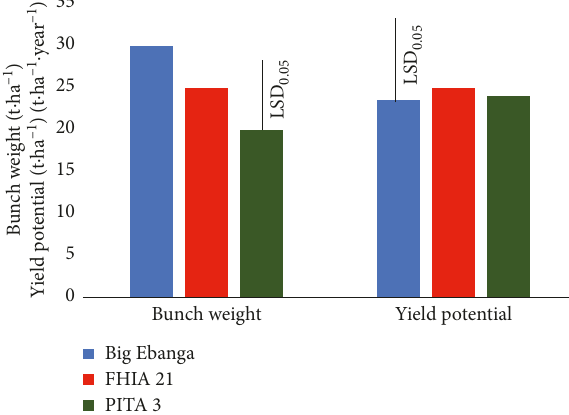
1 ) and yield potential (bunch weight Figure 4: Bunch harvest (t ha · 1 1 ) of medium-sized tetraploid plantain hybrids FHIA 21 year ha − · (ratoon cycle: 12months) and PITA 3 (ratoon cycle: 10months) − − along with giant false horn plantain “Big Ebanga” (ratoon cycle: +15months) in Co ̂ te